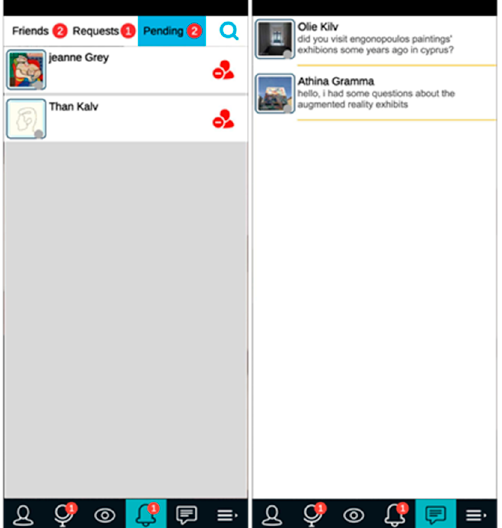
Figure 8. Two example screens of ARtful’s messaging system and friends list section.